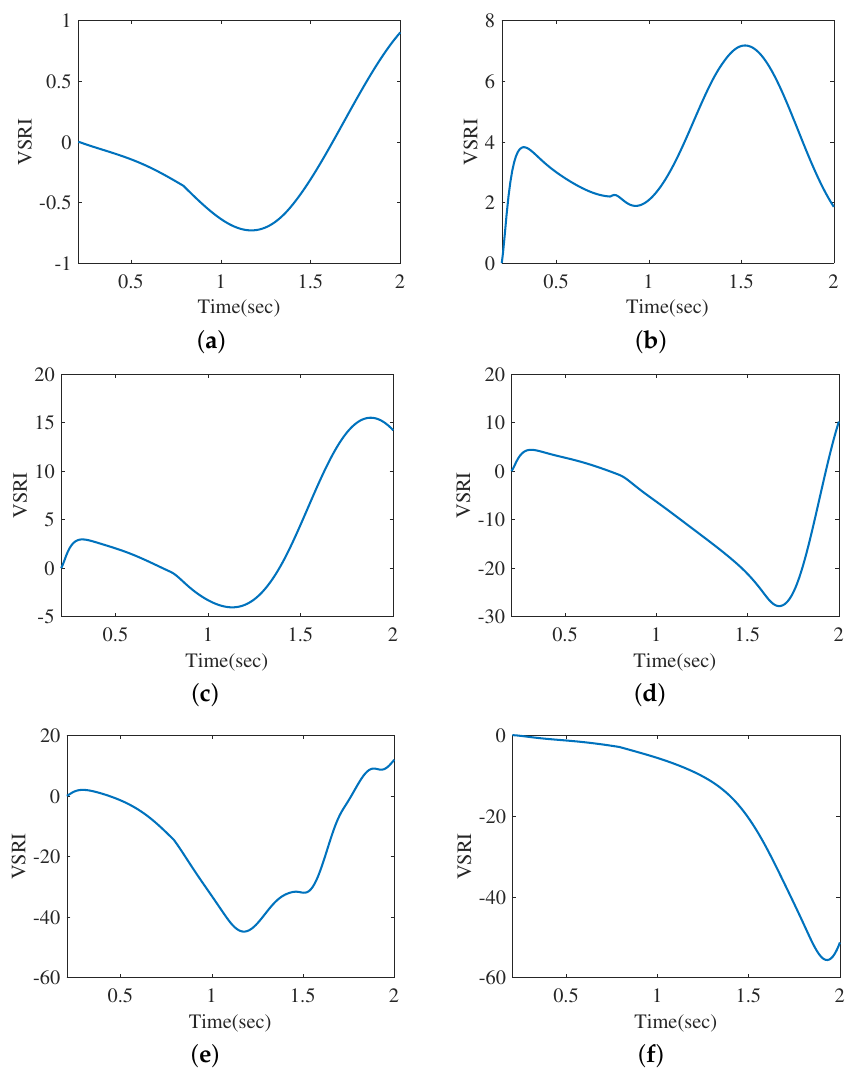
Figure 10. VSRI calculated for defined scenarios with N = 60: ( a ) Case a, ( b ) Case b, ( c ) Case c, ( d ) Case d, ( e ) Case e, ( f ) Case